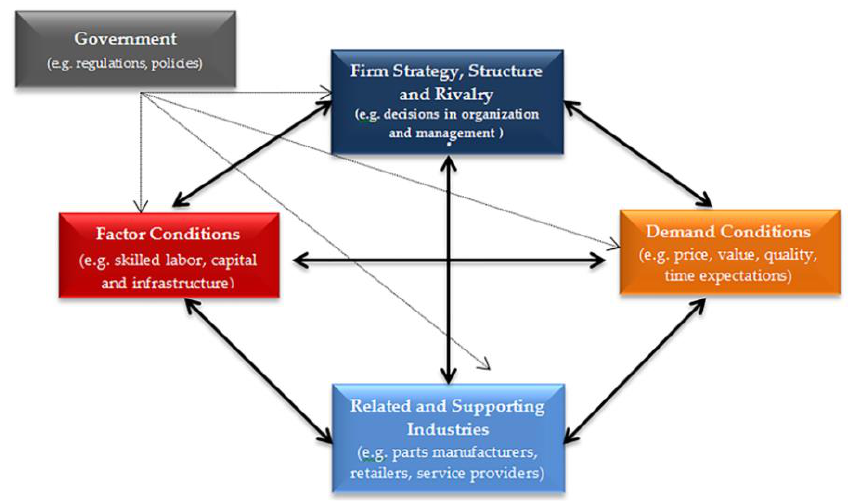
Figure 1. Porter’s diamond model. Source: Authors’ work.